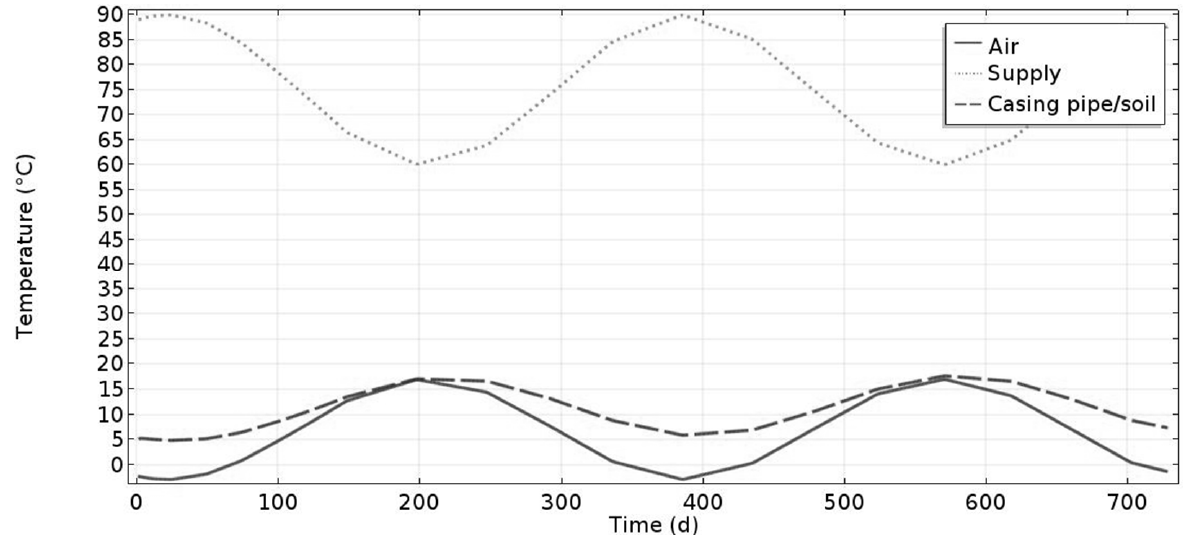
Figure 10. Seasonal variations in the casing pipe/soil temperature over two years; numerical calculations conducted in COMSOL Multiphysics.